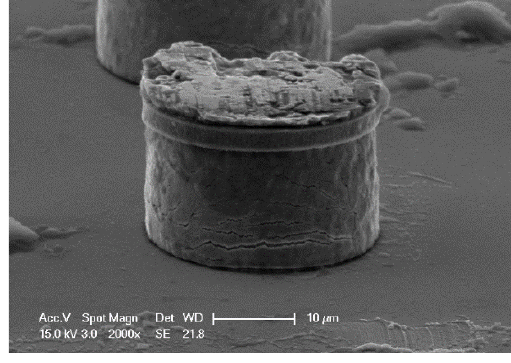
Figure 9. SEM image after shear test.